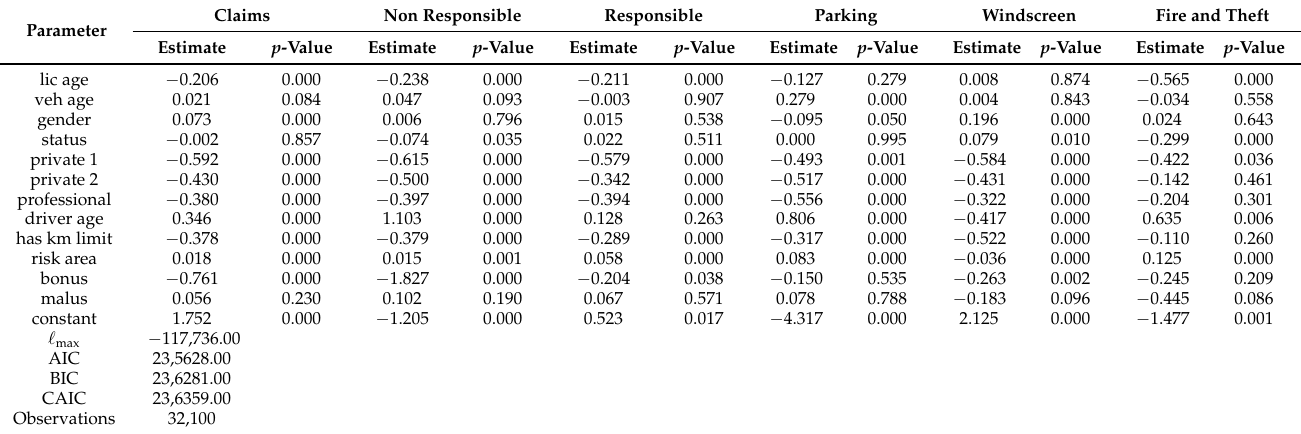
Table 6. Parameter estimates and p -values for the regression model with the density function (12). Some measures of the model selection are also